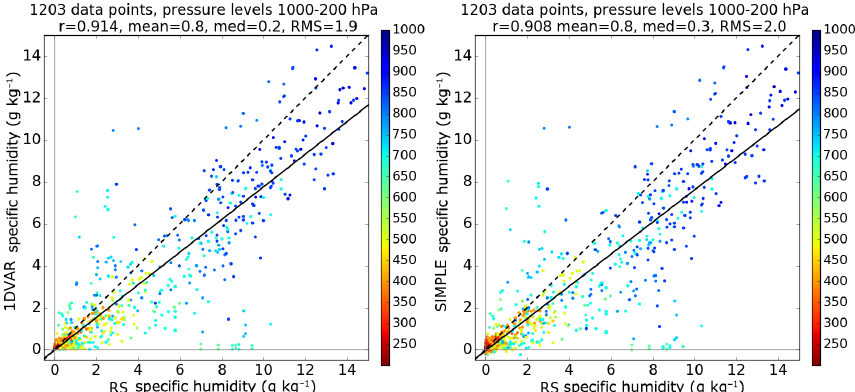
Figure A2. Specific humidity from the RO 1D-Var retrieval (left) and simple retrieval (right) versus radiosonde data. Collocation criteria: 2h 200km, altitude range 1000 to